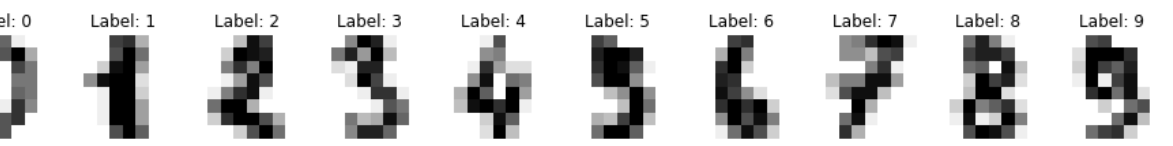
Figure 2. The visualization of 10 handwritten digits randomly chosen from the [30] dataset.